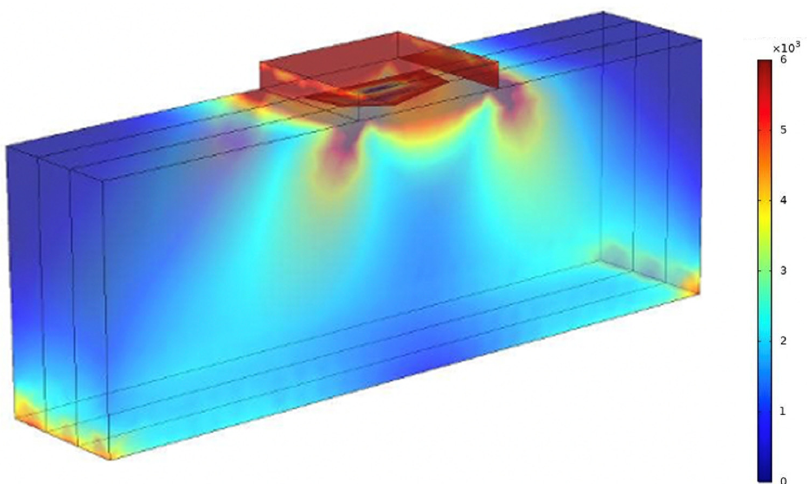
Figure 2. Distribution of von Mises stress (N/m 2 ) magnitude on the dressing and wound tissue. The stiffness of the tissue and dressing are 10 kPa and 50 kPa, respectively.